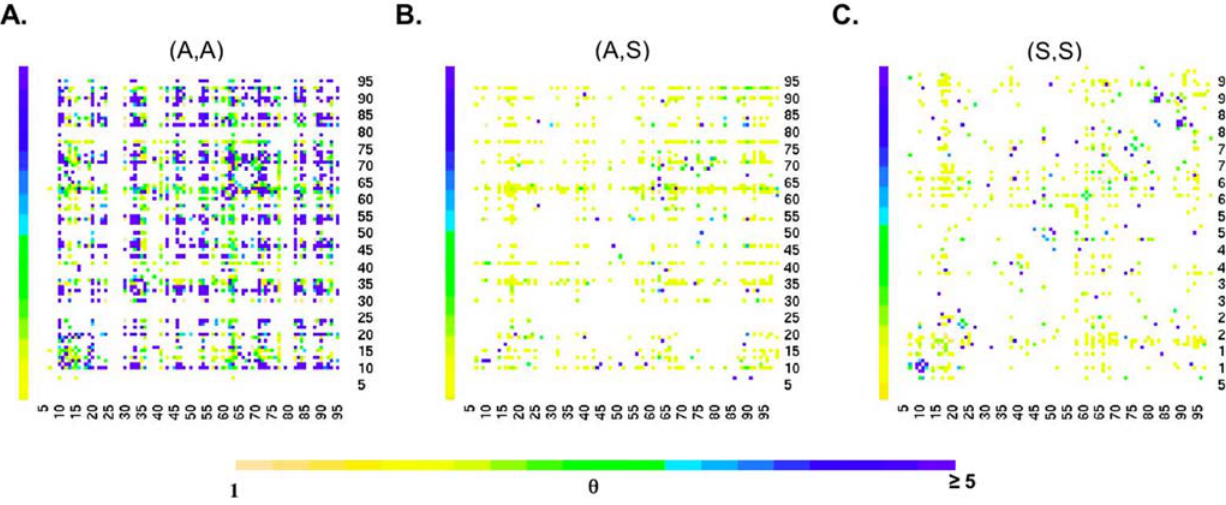
Figure 5. The Covariation Maps of Three Different Types of Mutation Pairs in HIV Protease. The covariation maps of A) amino acid mutation pairs (A,A), B) amino acid mutations to silent mutations (A,S) and C) silent mutation pairs (S,S). The X and Y axes represent the codon positions in protease. Each cell represents the strongest covariation value ( h ; see Materials and Methods) measured for any mutation pair of the designated type between the two positions. The strength of the covariation is depicted on a color scale, with yellow indicating covariation score ( h ) larger than 1 and varying shades up to blue indicating covariation score ( h ) larger than 5 (the covariation of two mutations is at least five times greater than random). White indicates no evidence of covariation.